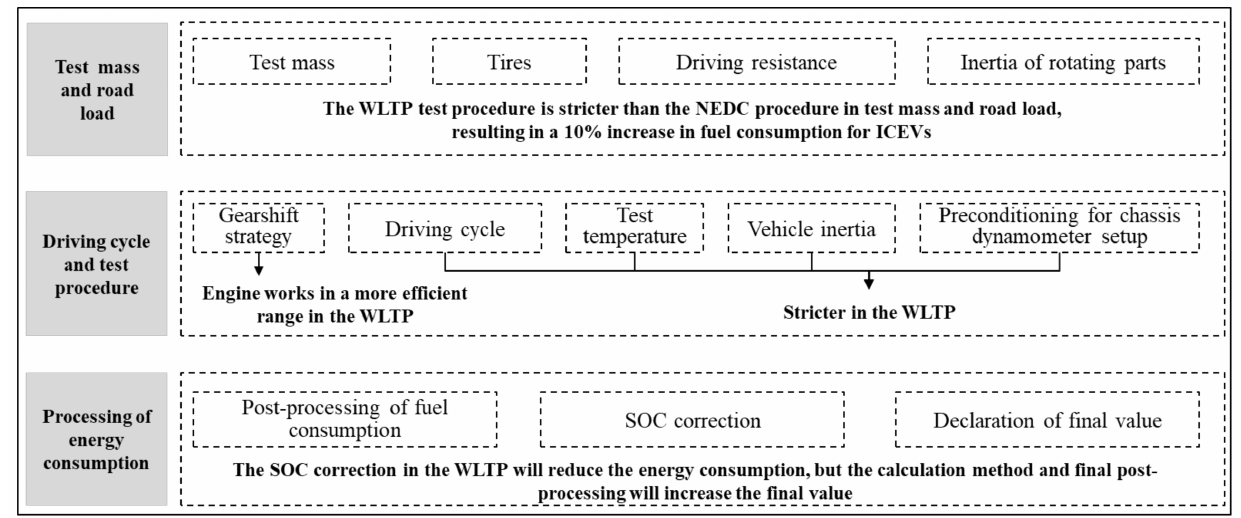
Figure 2. Summary of the NEDC and WLTP test procedure comparisons.